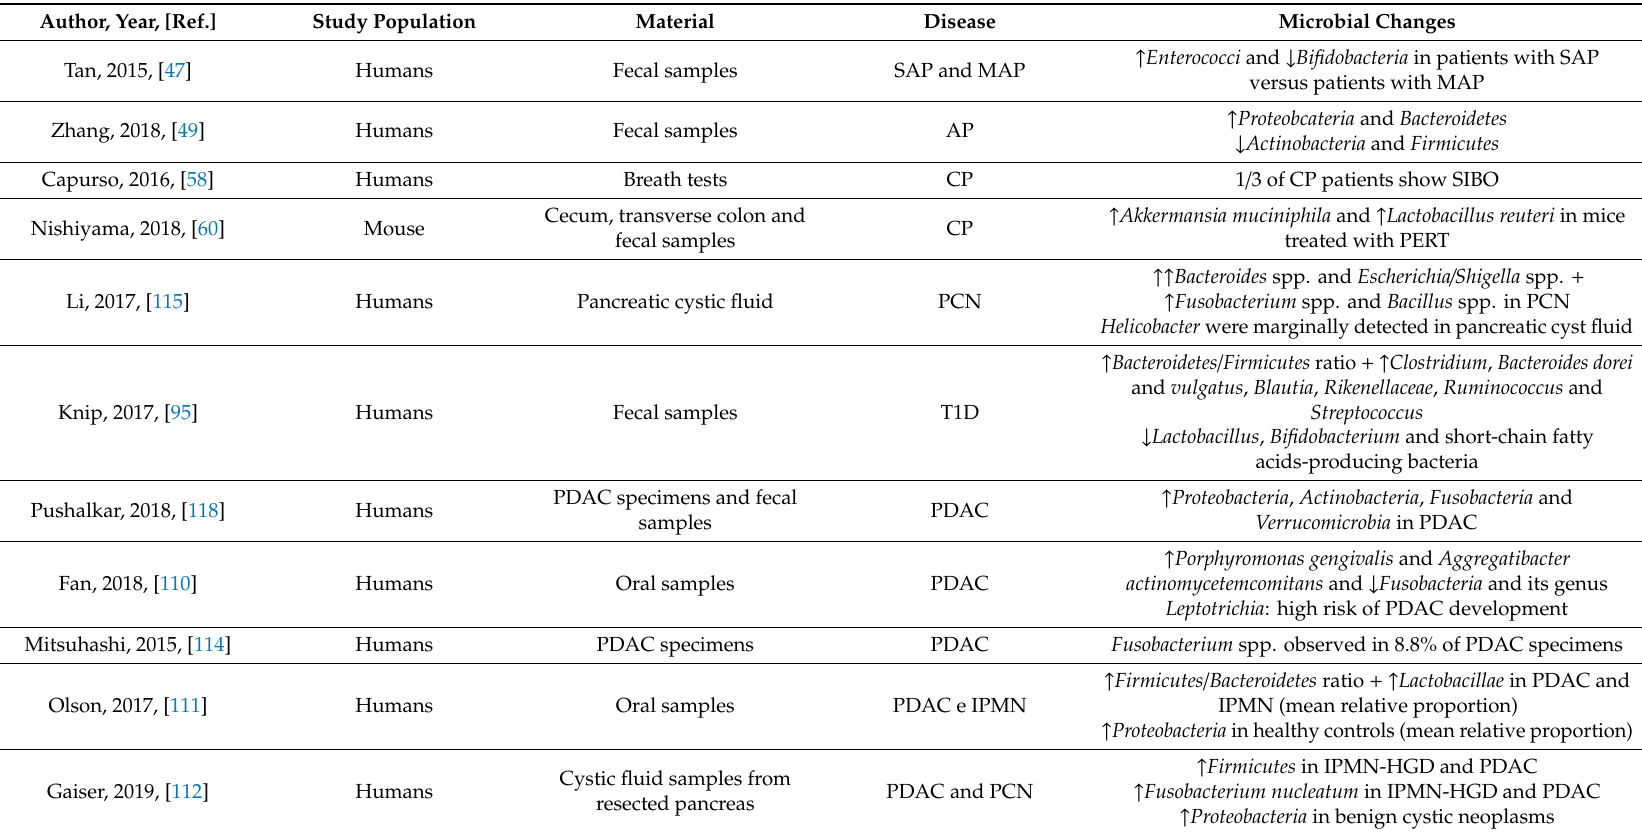
Table 2. Microbial changes in the pancreatic